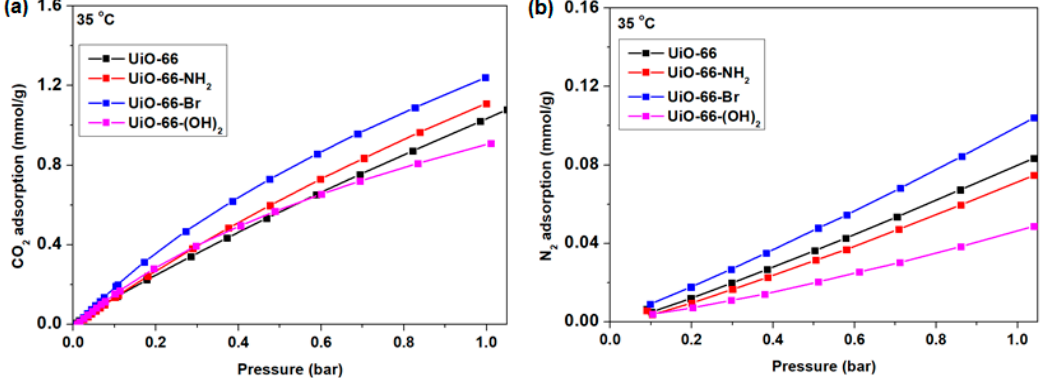
Figure 5. (a) CO 2 and (b) N 2 adsorption by nanocrystalline UiO-66 nanocrystals and its derivatives at 35 °C.